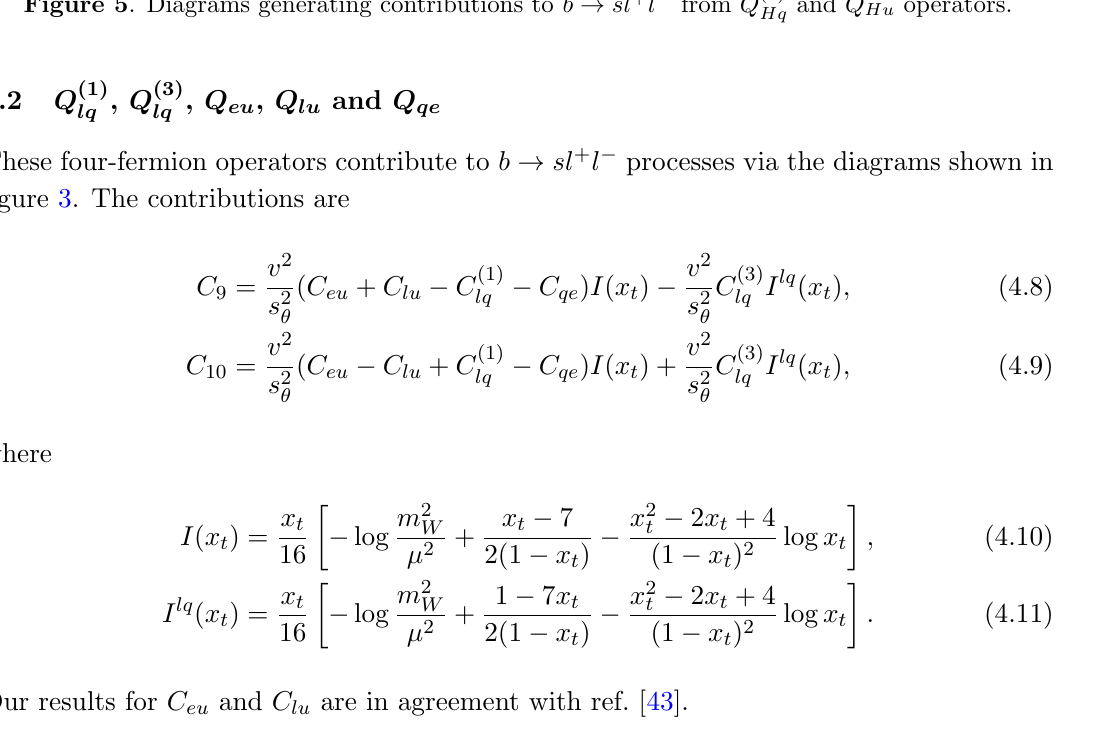
Figure 5 . Diagrams generating contributions to b ! sl + l (cid:0) from Q (1)